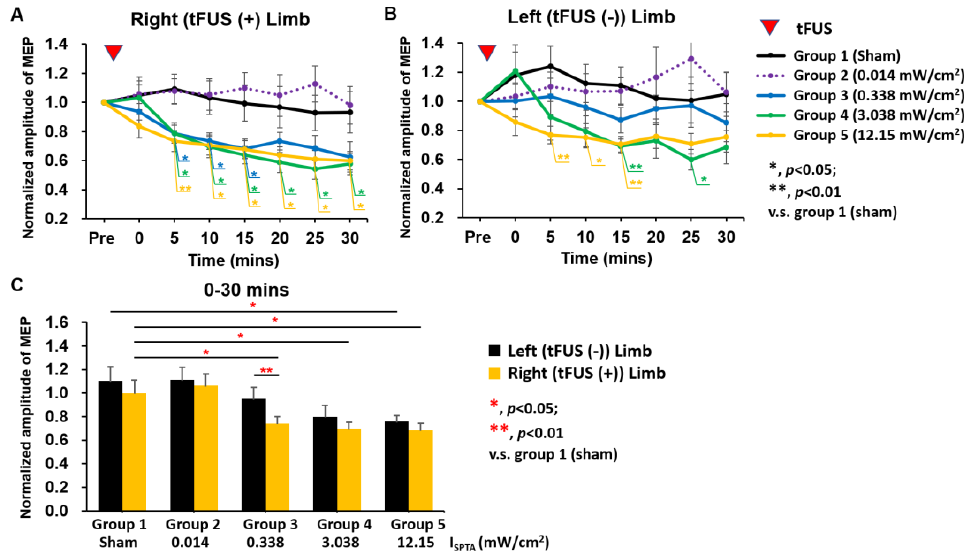
Figure 3. Overall changes in MEP in all groups. (A) Changes in right limbs (tFUS targeted) within 30 min after tFUS (B) Change in left limbs (tFUS untargeted) within 30 min after tFUS. (C) Change in both limbs at overall follow-up. (* and ** represent p values of <0.05 and <0.01, respectively).